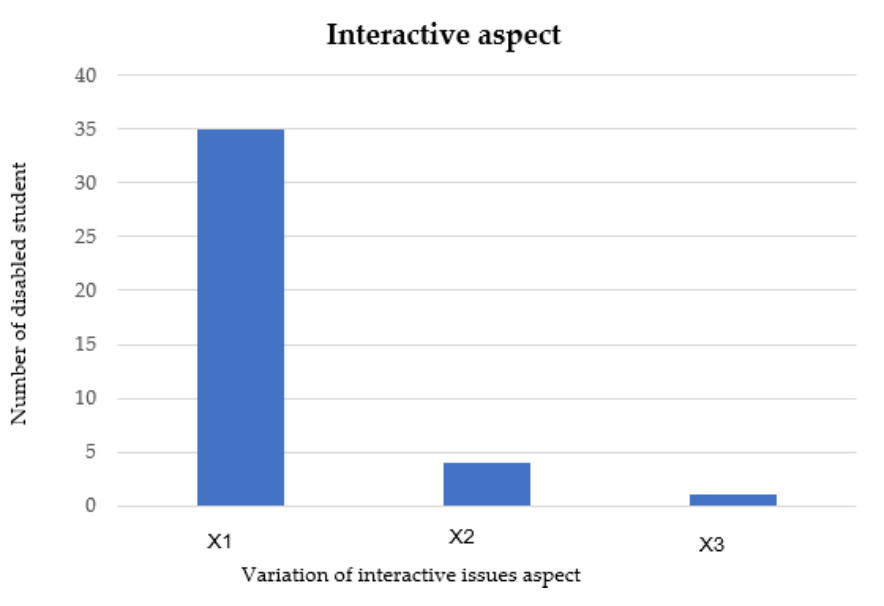
Figure 5. Interactive aspect of 3D virtual laboratory.